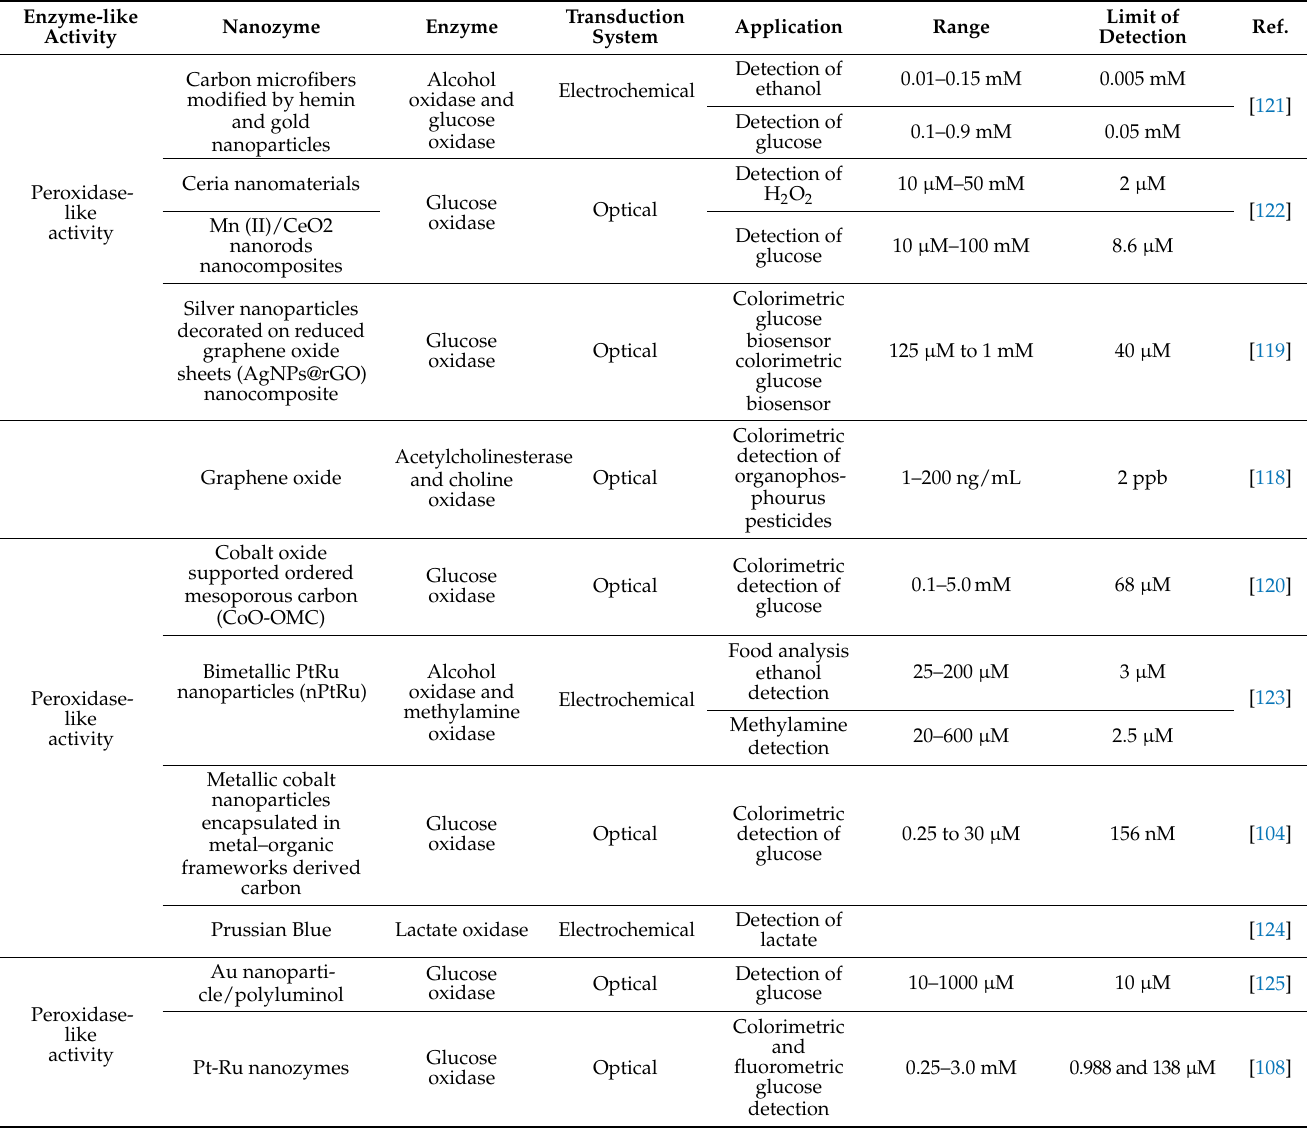
Table 7. Nanozyme-enzyme pool in